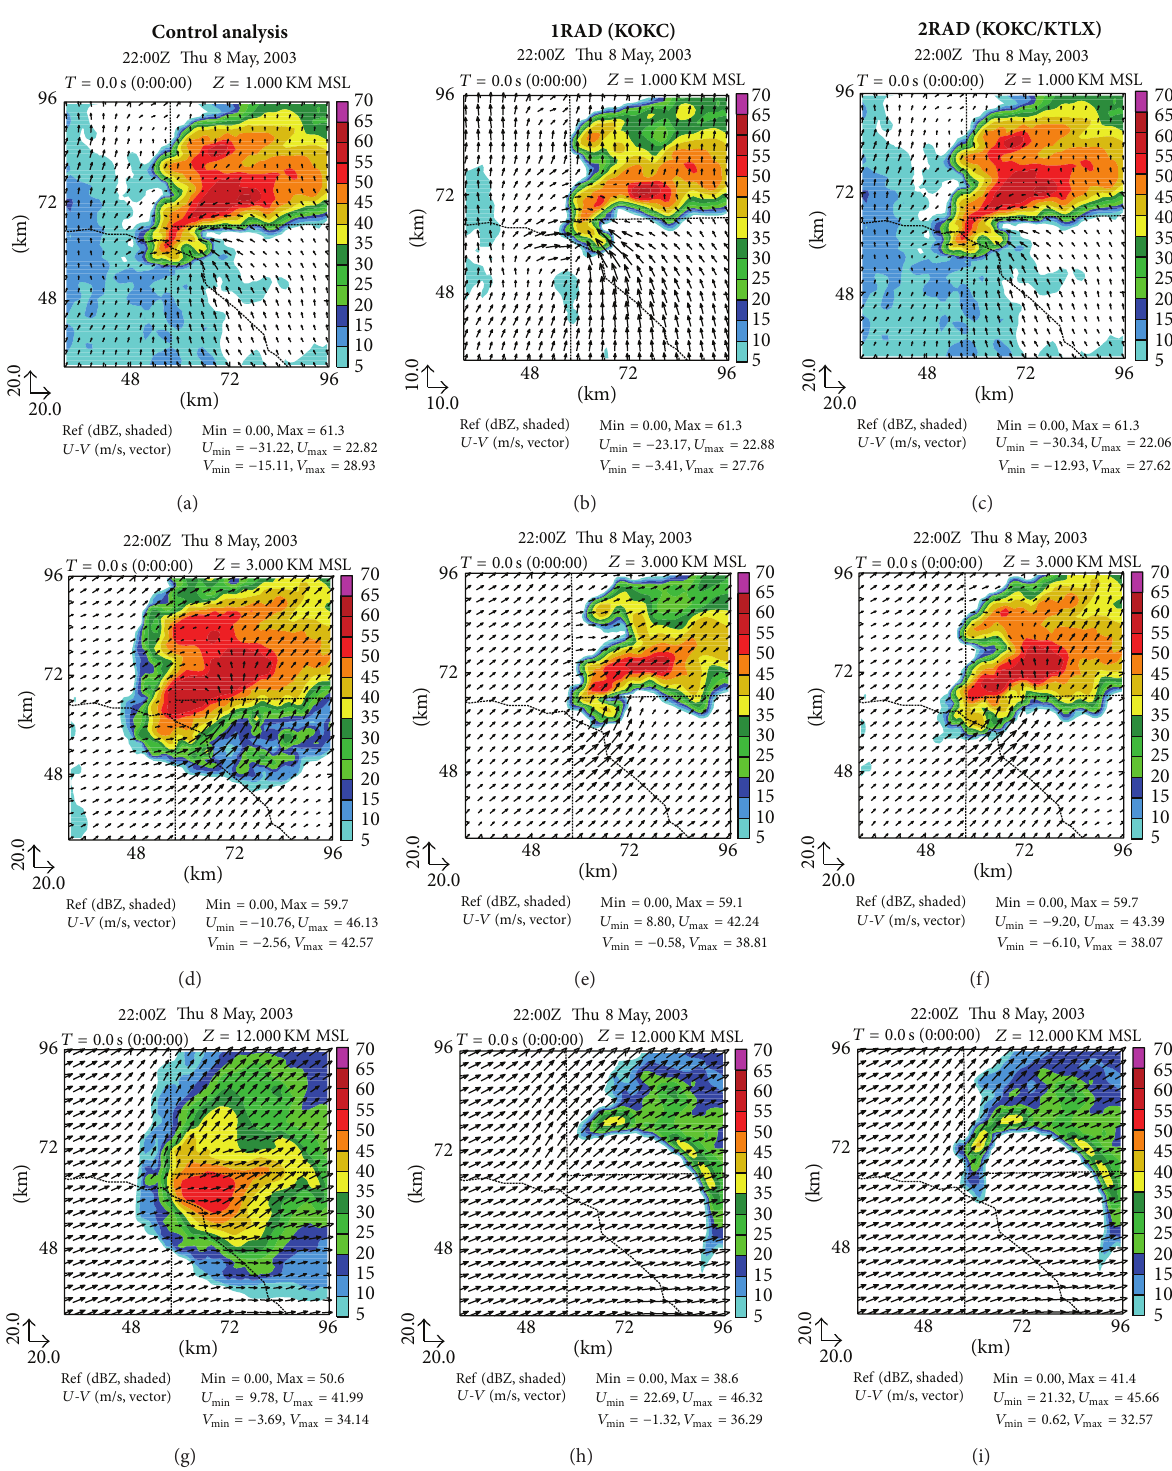
Figure 9: Reflectivity and horizontal wind vectors at 2200 UTC for the control analysis at (a) 1km, (d) 3 km, and (g) 12km level and for the 1RAD experiment ((b), (e), (h)) and for the 2RAD experiment ((c), (f),